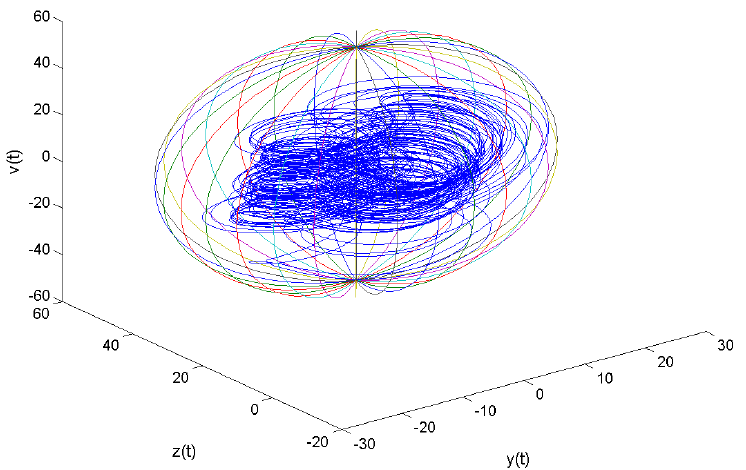
Figure 3. The trajectories of y ( t ) , z ( t ) and v ( t ) of the system ( 1 ) are restrained in Φ , where a = 10, 8 b = 3, c = 28, d = − 1, e = 10, r = 3 and the initial state ( x 0 , y 0 , z 0 , w 0 , υ 0 , u 0 ) = ( 1,1,1,1,1,1 )